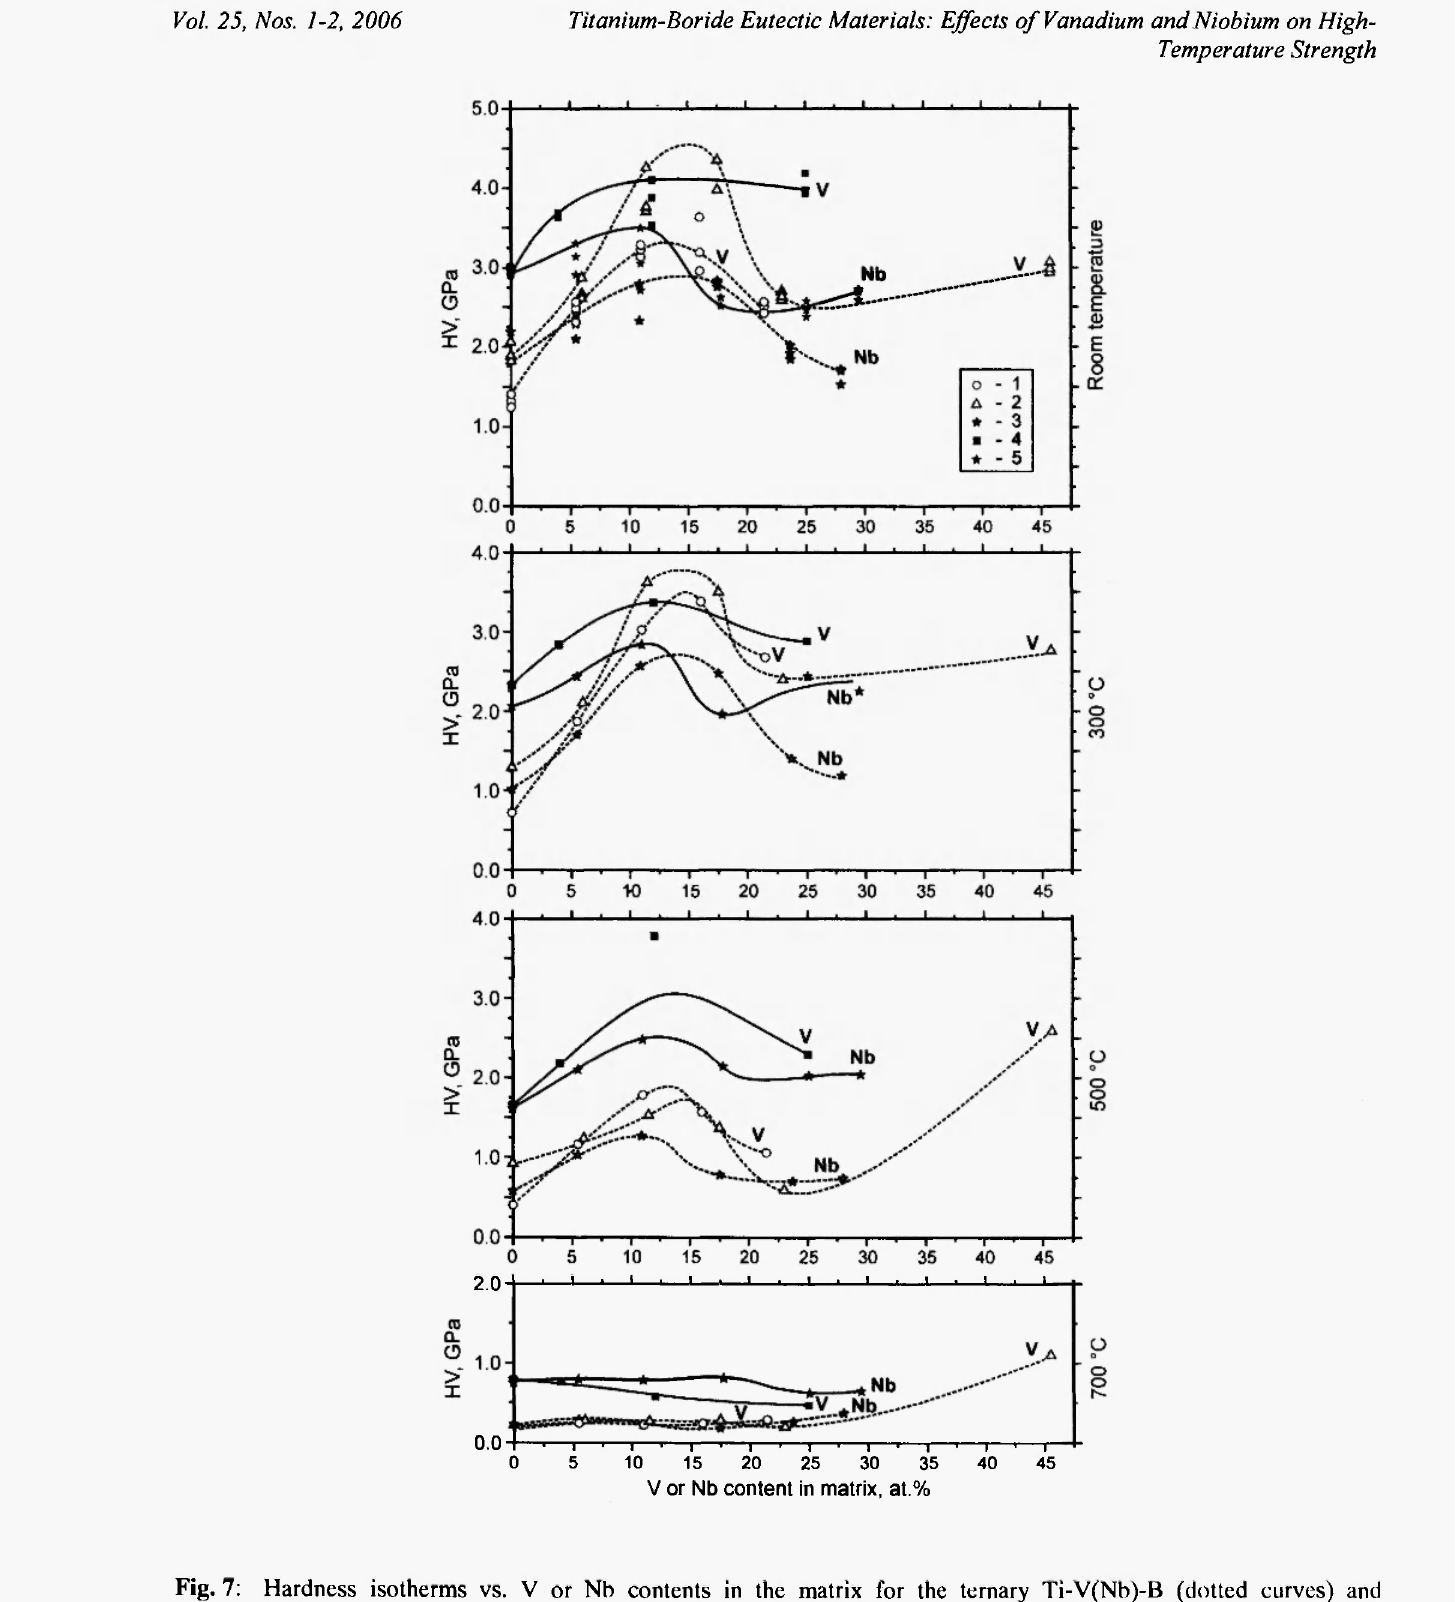
Fig. 7: Hardness isotherms vs. V or Nb contents in the matrix for the ternary Ti-V(Nb)-B (dotted curves) and quaternary Ti-Al-V(Nb)-B (solid curves) alloys. 1 and 2, ternary Ti-V-B alloys containing 5 and 9 at.% B. respectively; 3, ternary Ti-Nb-B alloys; 4 and 5, quaternary Ti-Al-V(Nb)-B alloys,